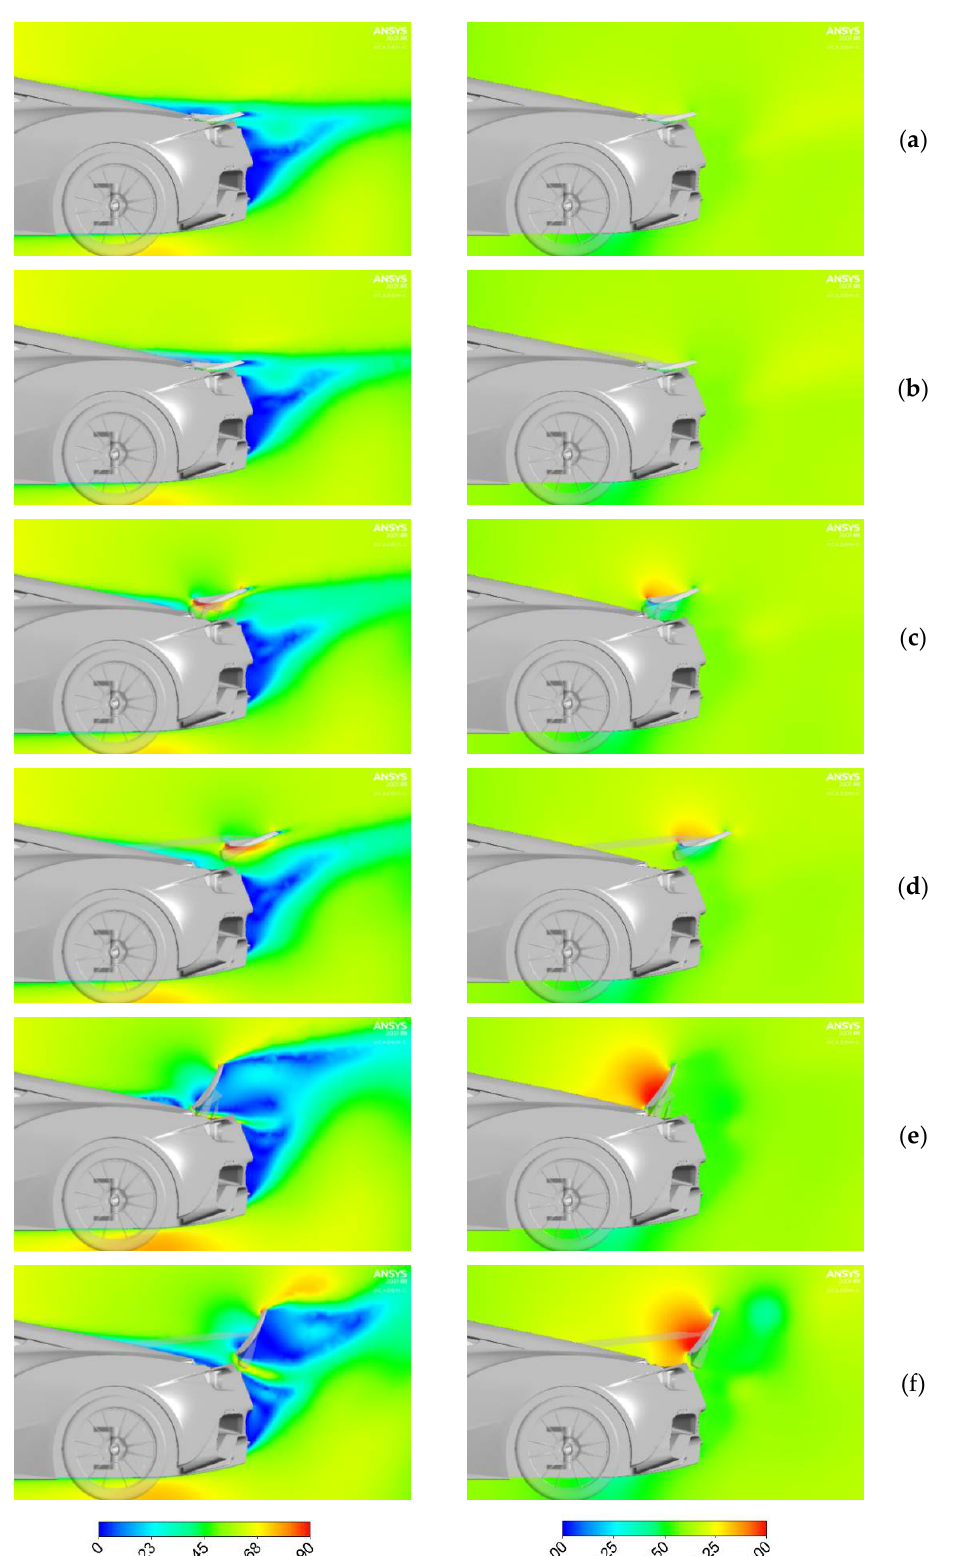
Figure 4. Contours of velocity (m/s) (left column) and pressure coefficient (right column) on the symmetry plane: ( a ) Wing retracted in the bottom-mounted configuration, and ( b ) top-mounted, ( c ) Performance mode—bottom-mounted, and ( d ) top-mounted, ( e ) Braking mode—bottom-mounted, and ( f ) top-mounted.